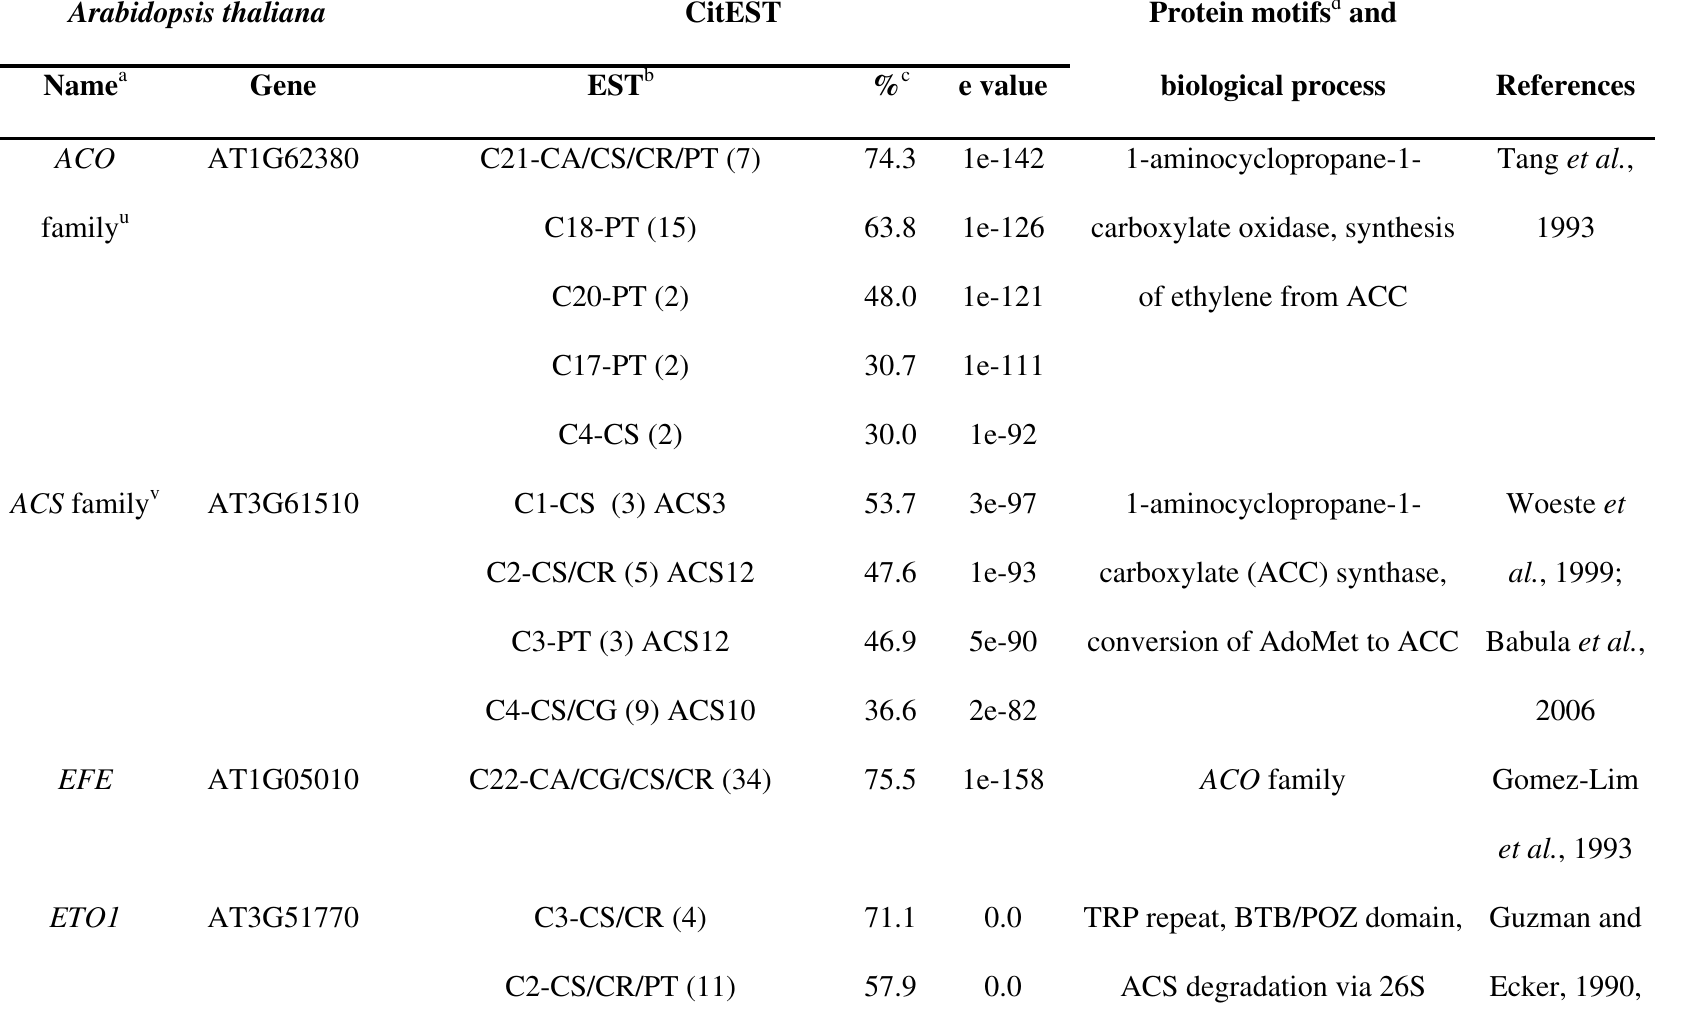
Table S8 – Citrus ESTs with homology to genes involved in ethylene biosynthesis in Arabidopsis thaliana . Arabidopsis